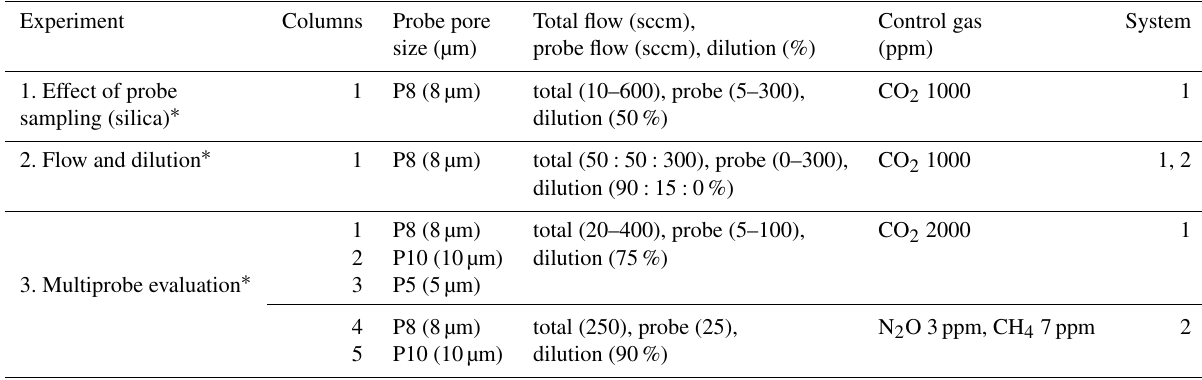
Table 3. Experiments under controlled conditions with the silica matrix using Systems 1 and 2. Experiment